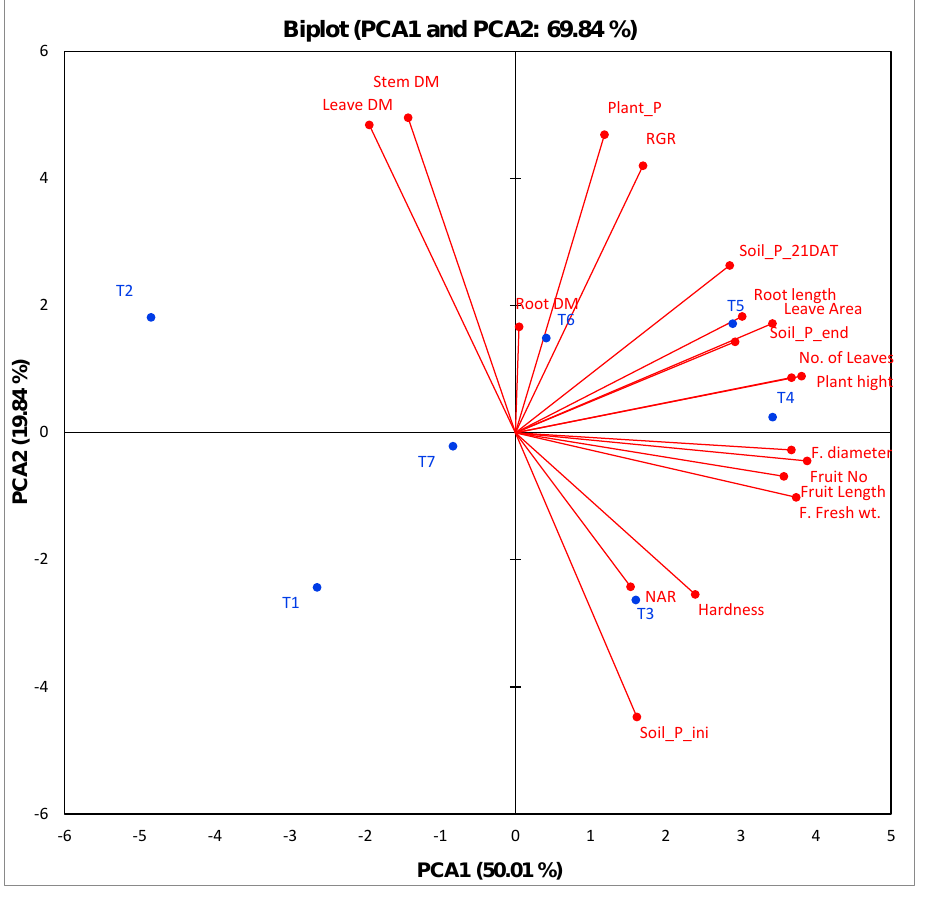
Figure 6. PC-biplot exploring the relationship between the evaluated traits under treatments of rock phosphate and Streptomyces strains as plant growth-promoting agents.